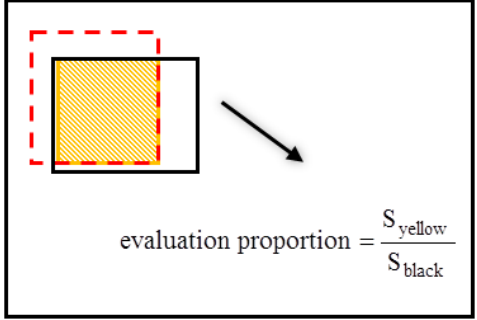
Figure 10. The definition of evaluation grade. The yellow area is the identified effective area. The black frame area is model’s total area. The above proportion is the ratio between yellow area and black area.